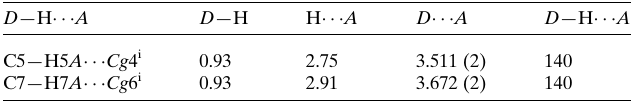
Table 1 Hydrogen-bond geometry (A˚ , (cid:2) ). Cg 4 and Cg 6 are the centroids of the C18/C19/C24–C26/C31 and C26–C31 rings, respectively.